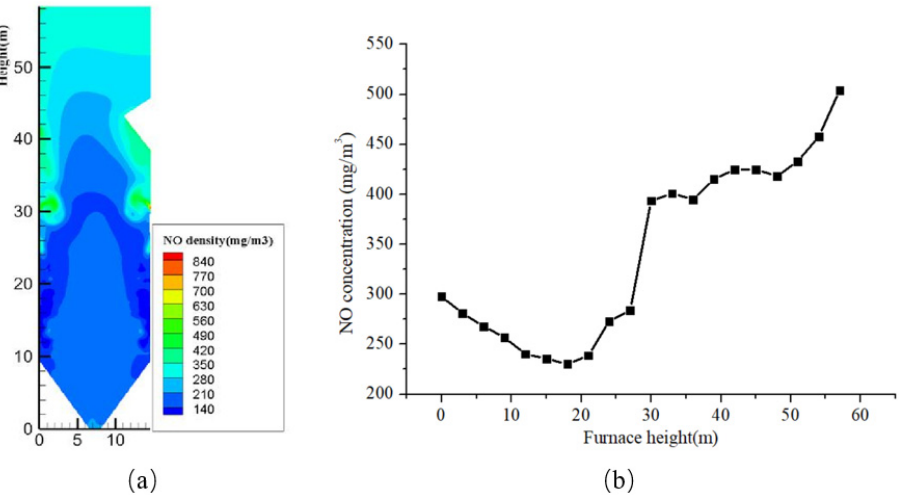
Figure 6. Distribution diagram of NO concentration in 350 MW furnace (mg/m 3 ). ( a ) NO concentra- tion contours of central longitudinal section. ( b ) NO concentration curve with height.